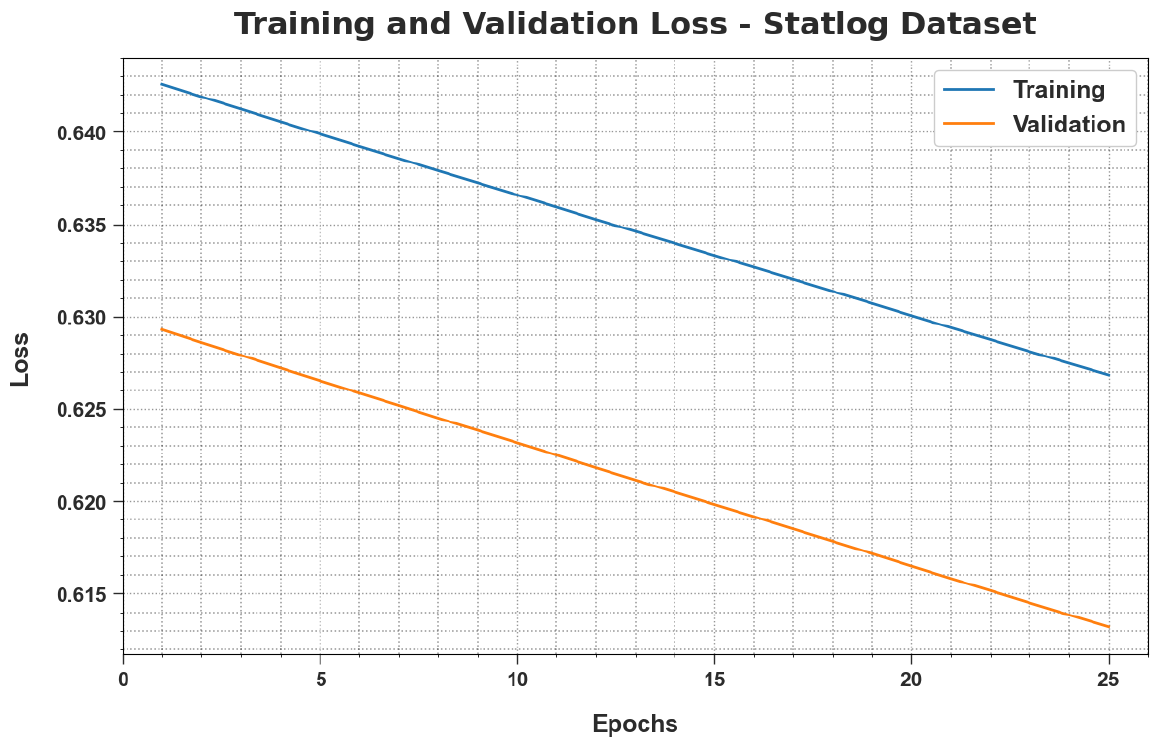
Figure 10. 𝑇𝑅 𝑎𝑐𝑐 and 𝑉𝐿 𝑎𝑐𝑐 analyse the results of the MLMDMC-ED algorithm on the Figure 10. TR acc and VL acc analyse the results of the MLMDMC-ED algorithm on the Statlog dataset. Statlog dataset.